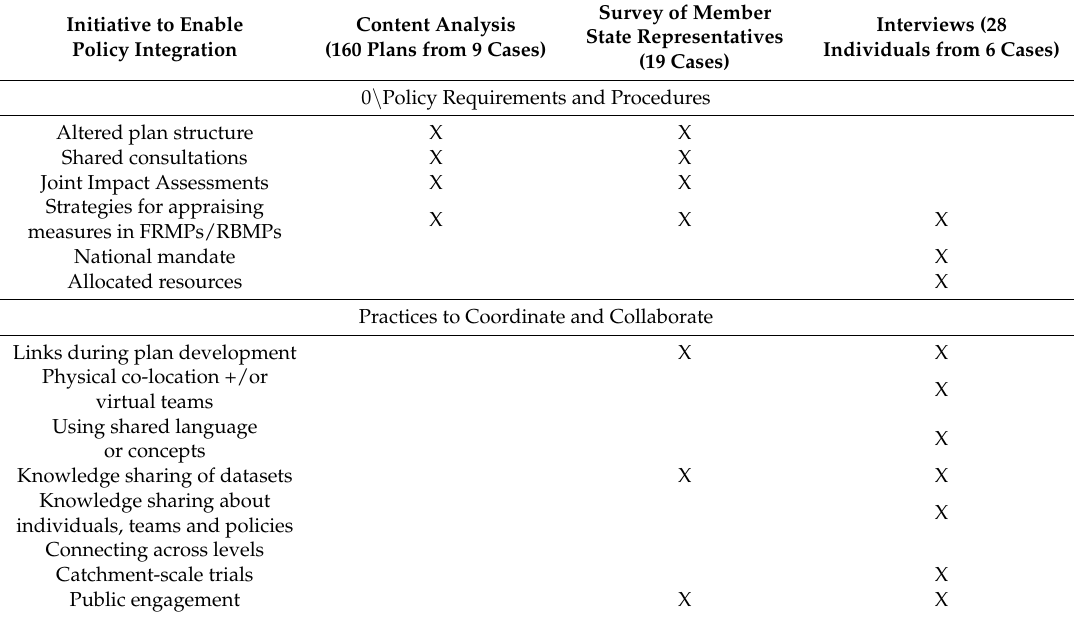
Table 1. A summary of the formal and informal initiatives for integration reported in our data. “X” represents the presence of initiative in one or more cases analysed. The most important initiatives, and connections between these, are discussed in the main